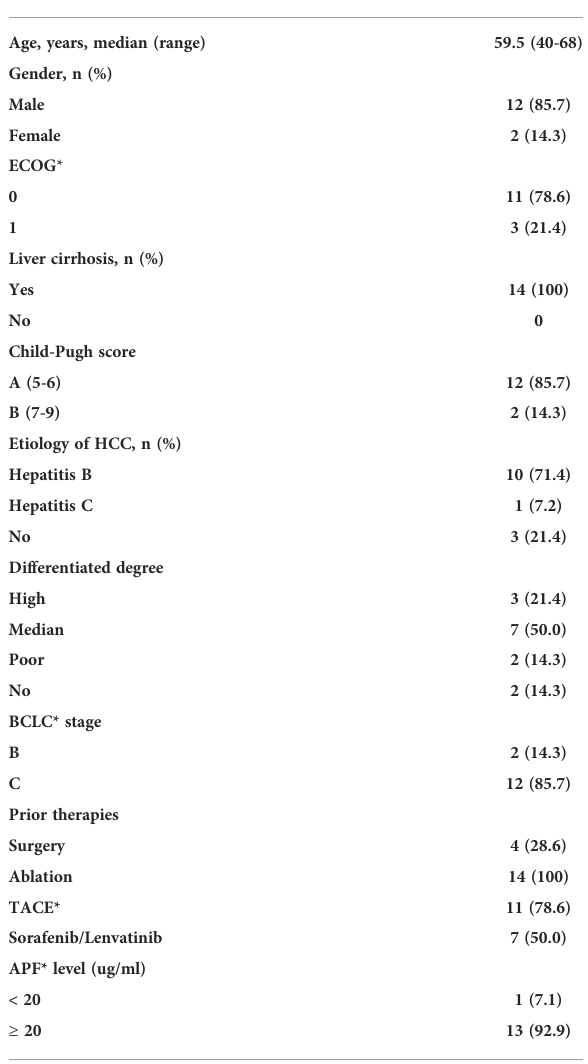
TABLE 1 Baseline characteristics of study population (n = 14).